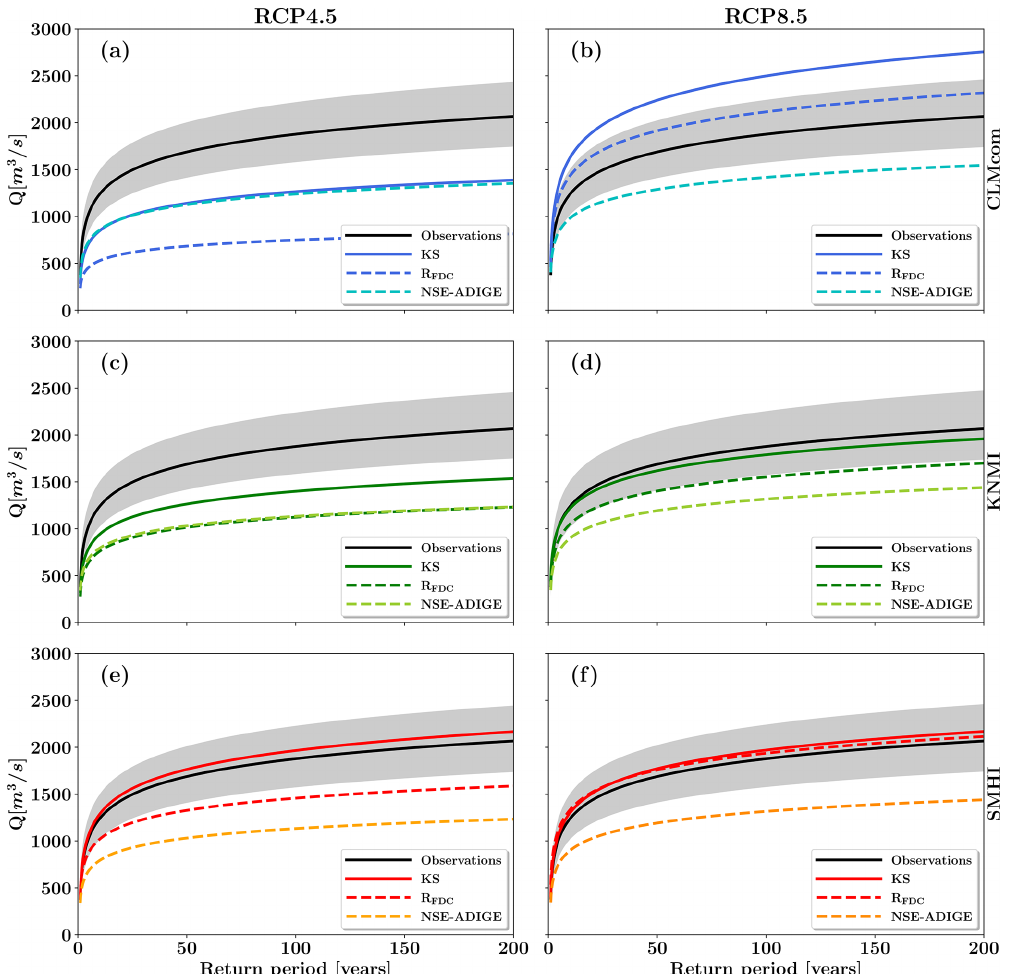
Figure 8. Quantiles of the annual maximum daily streamflow as a function of return period at the Trento gauging station. Projections are based on simulations of the future time period from 2042 to 2070 using the CLMcom (a, b) , KNMI (c, d) and SMHI (e, f) climate models under the respective RCP4.5 (a, c, e) and RCP8.5 (b, d, f) emission scenarios as input. The continuous black line shows the quantile distribution of high flow extremes evaluated with the observational data of the 1982–2010 period, and the gray shaded area indicates the associated 90% confidence interval of the fitted Gumbel